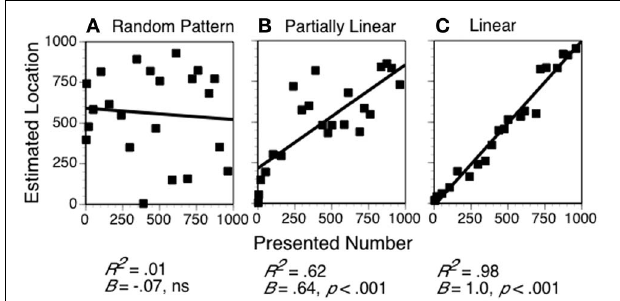
FIGURE 1 | Examples of different forms of the relation between numbers presented and locations selected in the number line task, (A) random pattern of responses, (B) partially linear pattern, and (C) linear pattern. Data are from three participants from grade 2 in the current study. The model fits and slope values are shown below the